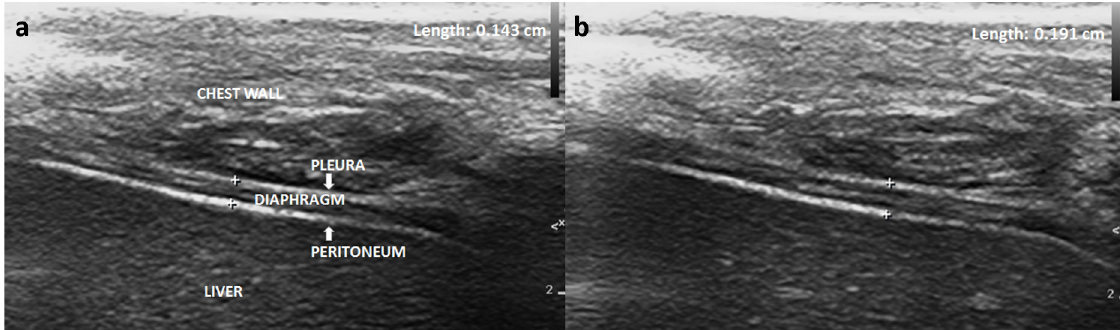
Fig 1. Diaphragm ultrasound at the zone of apposition. (a) Thickness measurement at end-expiration, (b) Thickness measurement at end-inspiration.